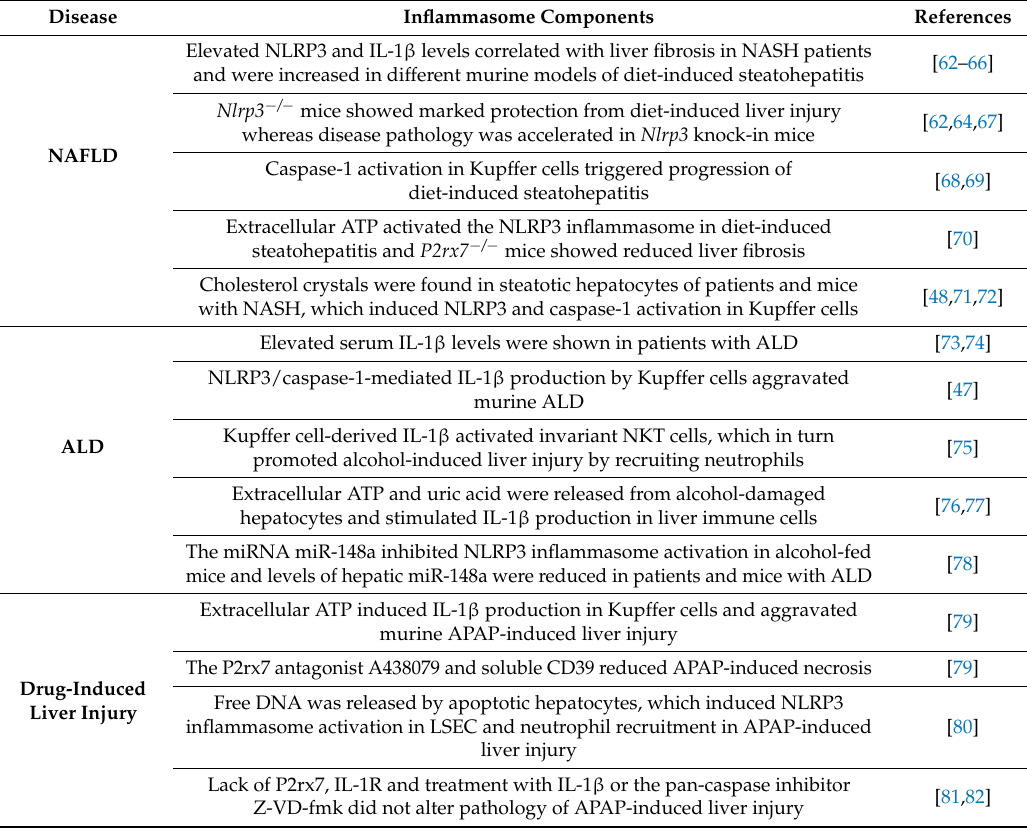
Table 1. List of inflammasome components in sterile liver